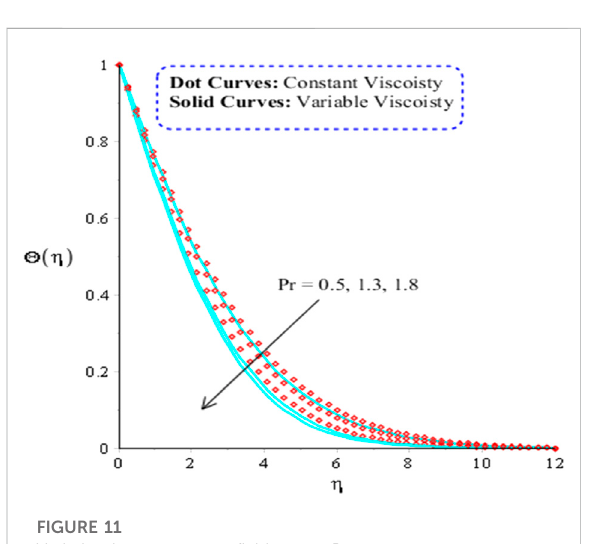
FIGURE 13 Variation in temperature fi eld versus Θ γ